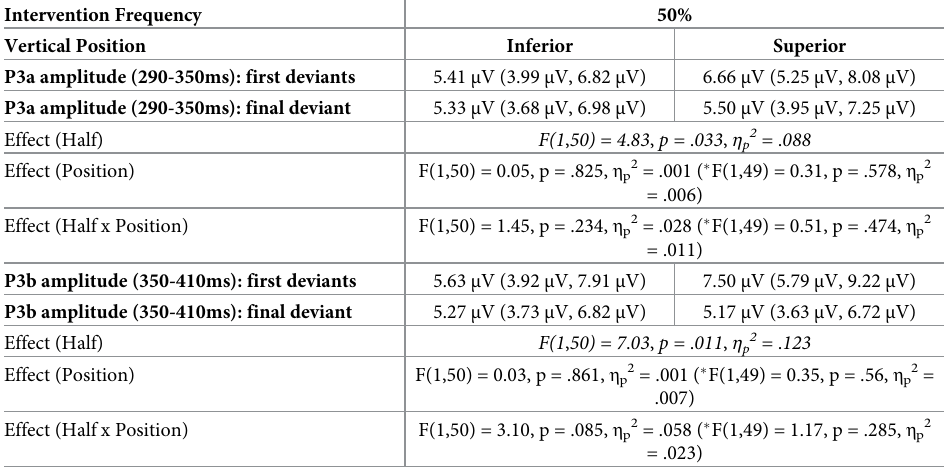
each mean, the upper and lower limits of confidence intervals (95%) are additionally provided in brackets. ANOVA results for the factor vertical position are additionally controlled for the covariate ’age of participant’ in an ANCOVA. All ANCOVA results are indexed by an asterisk ( �